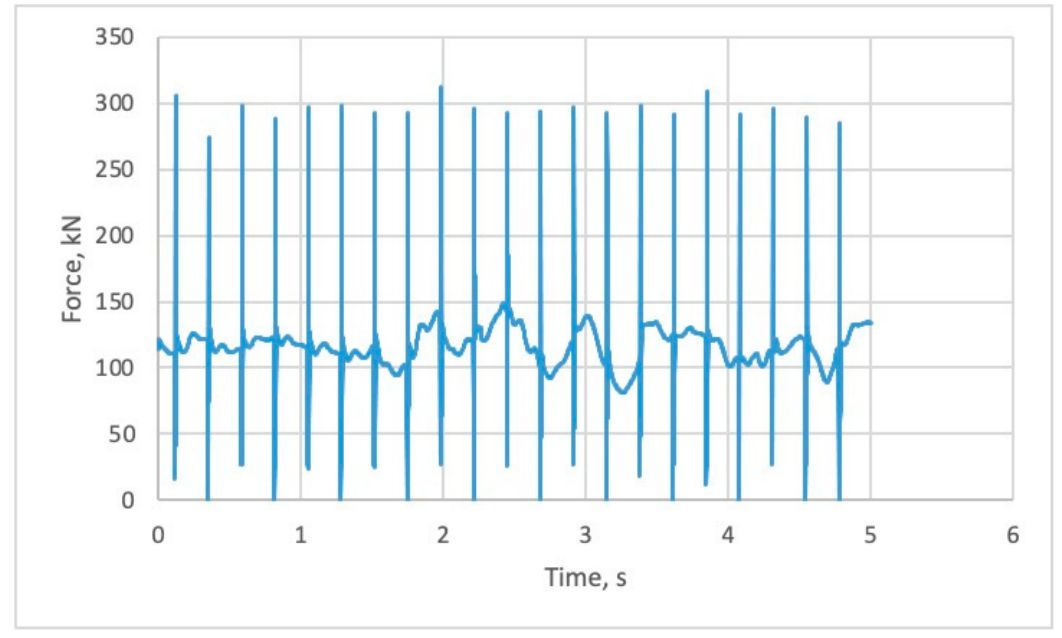
Figure 10. Calculated force values of the 71st wheelset.